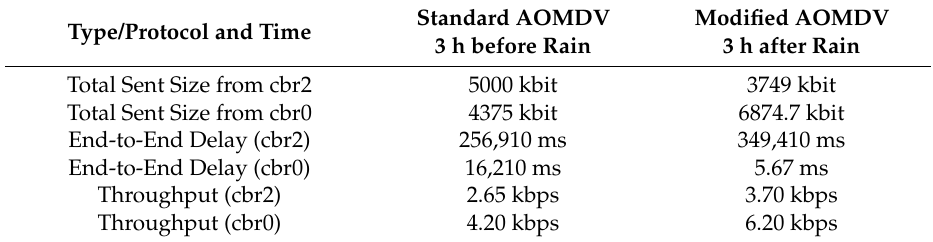
Table 4. Performance Measurement before and during the time when node 0 is affected by rain.